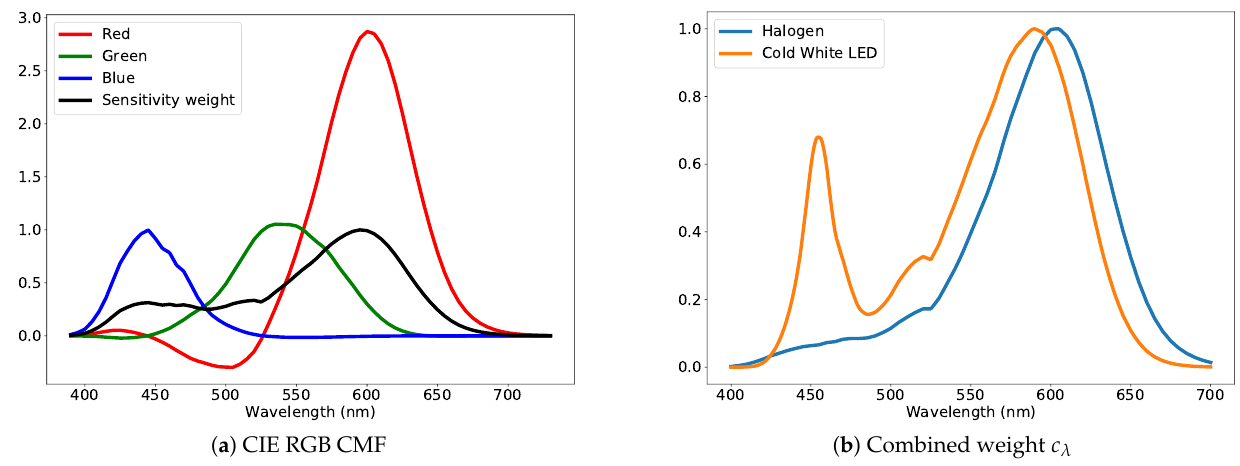
Figure 7. ( a ) CIE RGB color matching functions used as a proxy for camera sensor spectral sensitivity. The mean of the absolute values (in black) was used as a single proxy for sensor sensitivity. ( b ) Combined weight c λ calculated from the sensitivity weight and illuminant